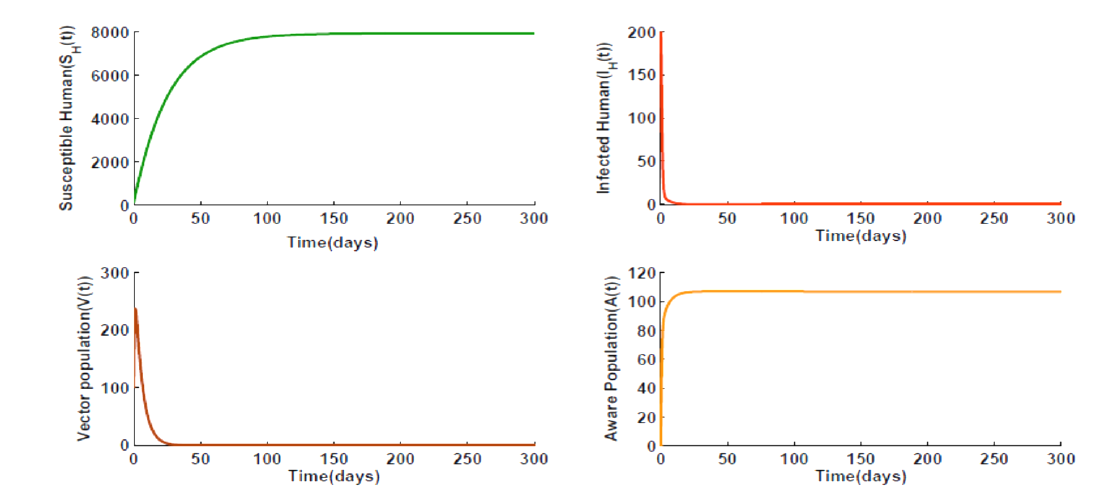
Fig. 4. Population density as a function of time when awareness campaigning is circulated by media